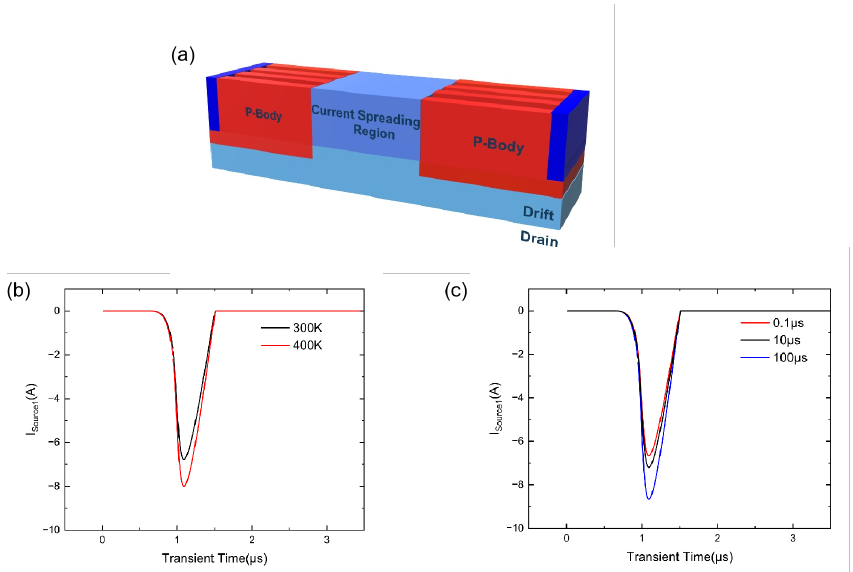
Figure 7. ( a ) Schematic view of no SBD structure. Recovery characteristics with different ( b ) tempera- tures, and ( c ) lifetimes.